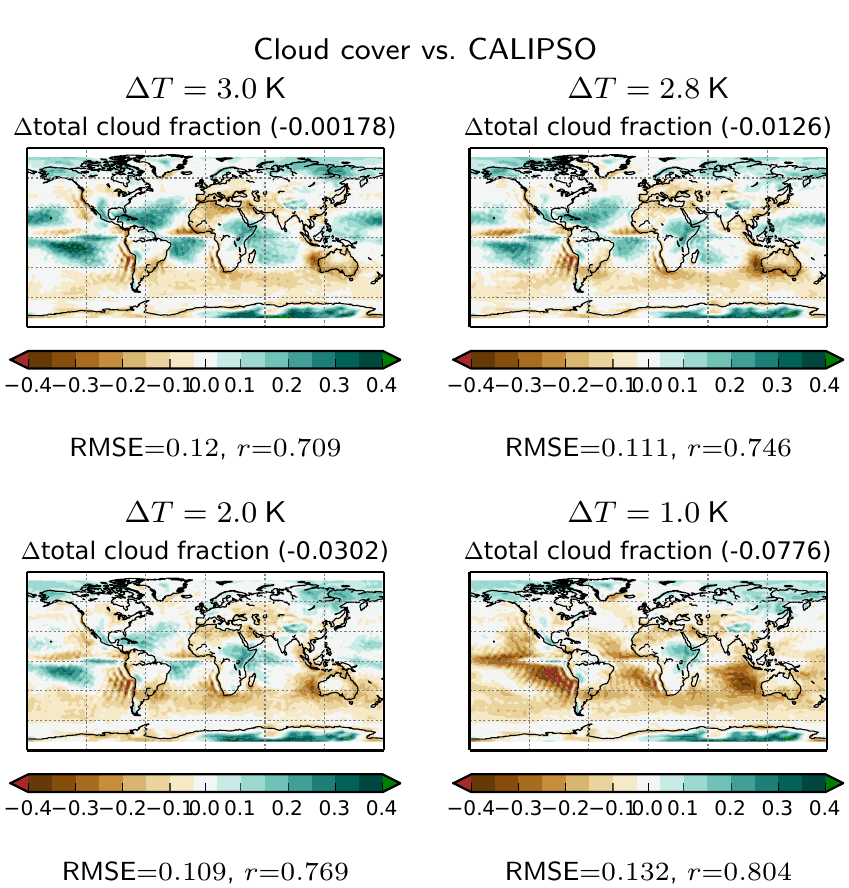
Figure 6. Difference in annual mean COSP-simulated cloud fraction between 1-year simulations using ECHAM–HAM with CCFM (L − 2) and CALIPSO–GOCCP, as a function of the temperature perturbation used to initiate the subcloud